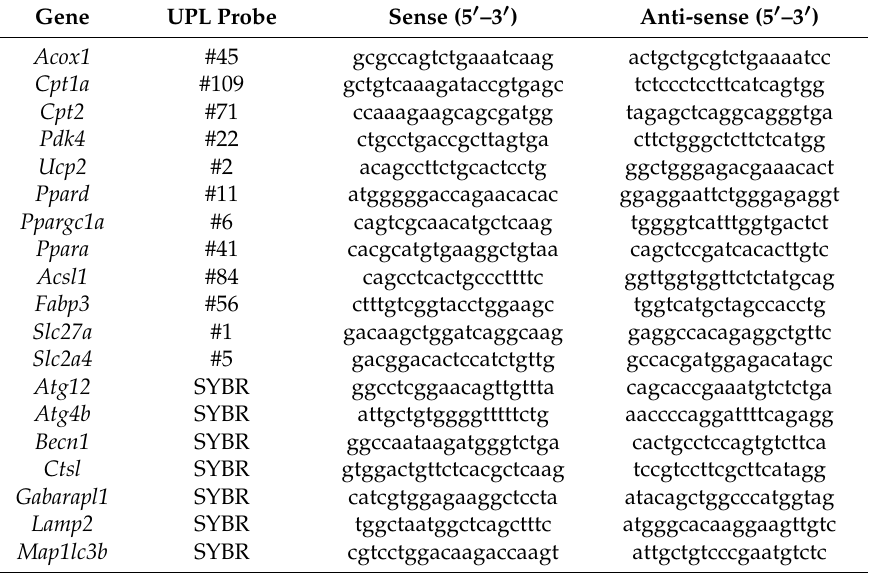
Table 2. Probes and primers used for qPCR